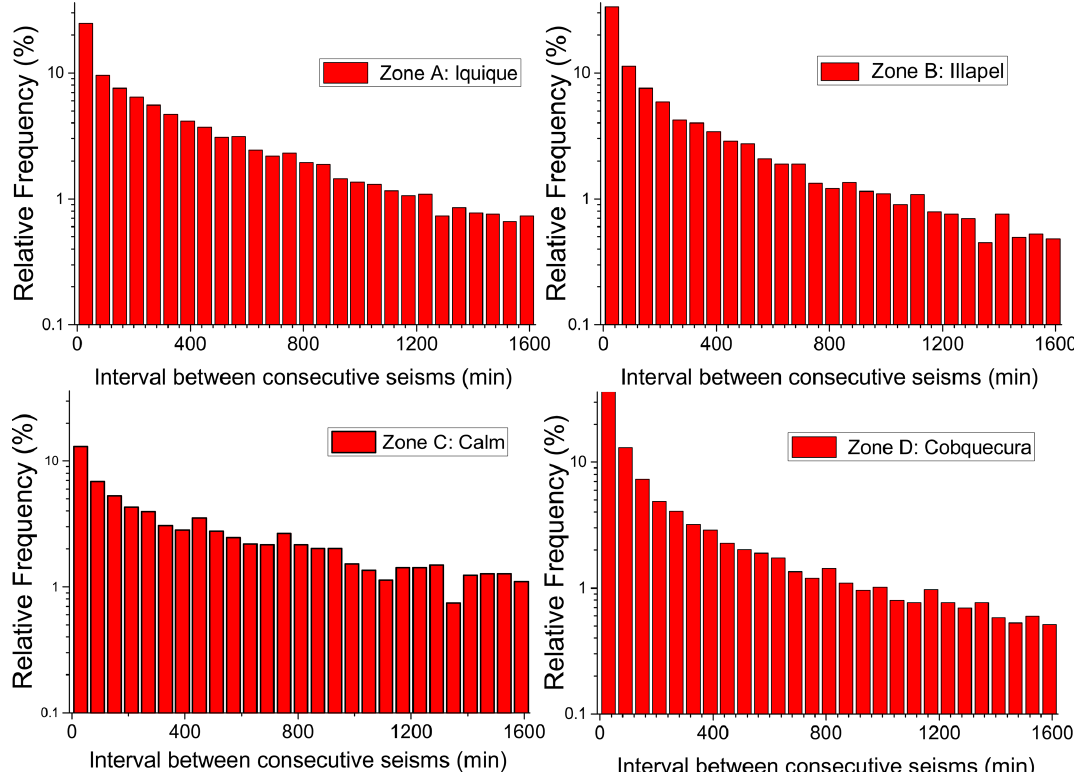
Figure 2. Distribution functions G Z,i ( Z = {A, B, C, D}) for intervals between two consecutive seismic events.